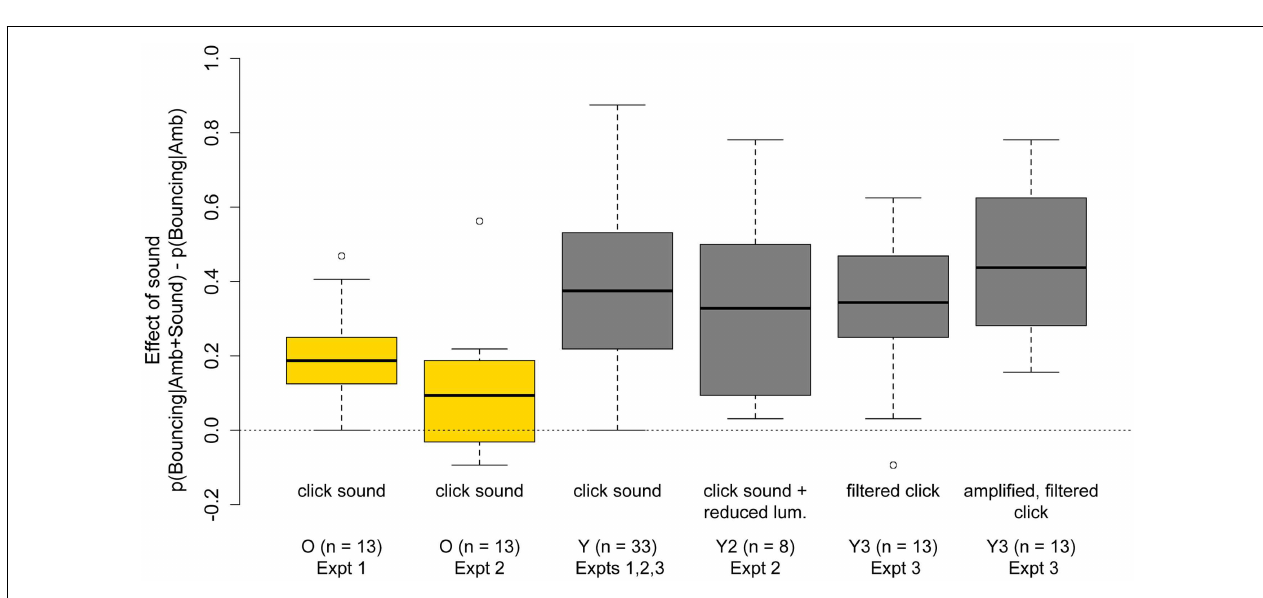
younger subjects across Experiments One,Two, andThree.The fourth boxplot shows the bouncing bias induced by the click sound in ExperimentTwo when display luminance was reduced with neutral density filters.The fifth and sixth boxplots show the bouncing bias induced by the filtered and filtered-and-amplified clicks for 13 younger subjects in